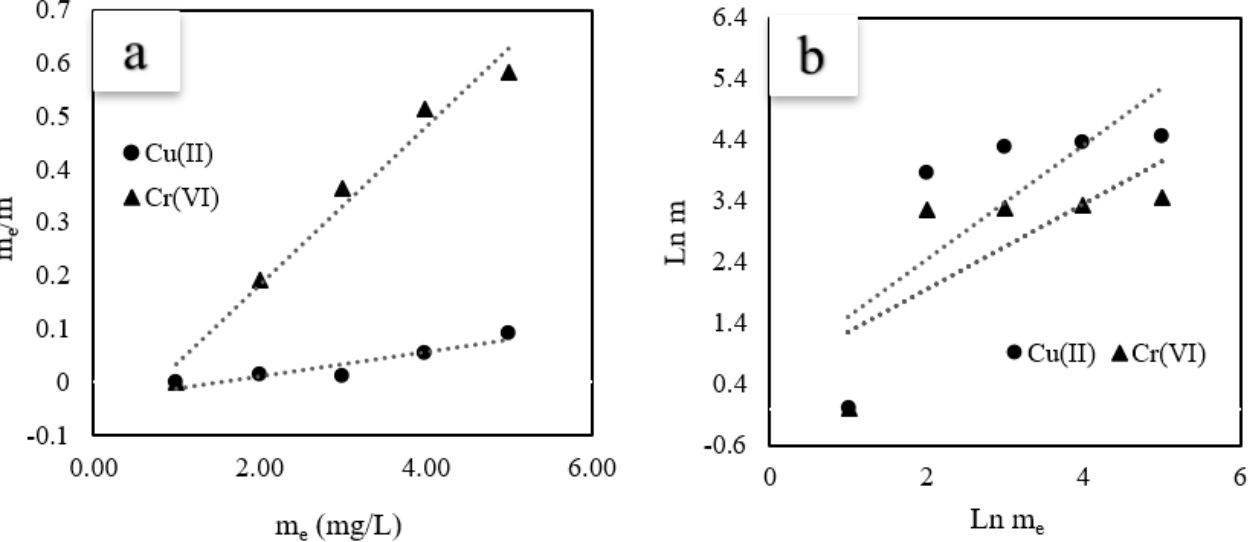
Figure 5. Linear curves of adsorption isotherm studies. ( a ): Langmuir, ( b ): Freundlich. (C-ZLCH: 0.01 g, volume (mL): 50, pH: 8.1 for Cu(II), 6.7 for Cr(VI), temperature: 30 °C, and time: 30 min). Table 1. Isotherm model parameters for Cu(II) and Cr(VI) adsorption onto C-ZLCH. Adsorption